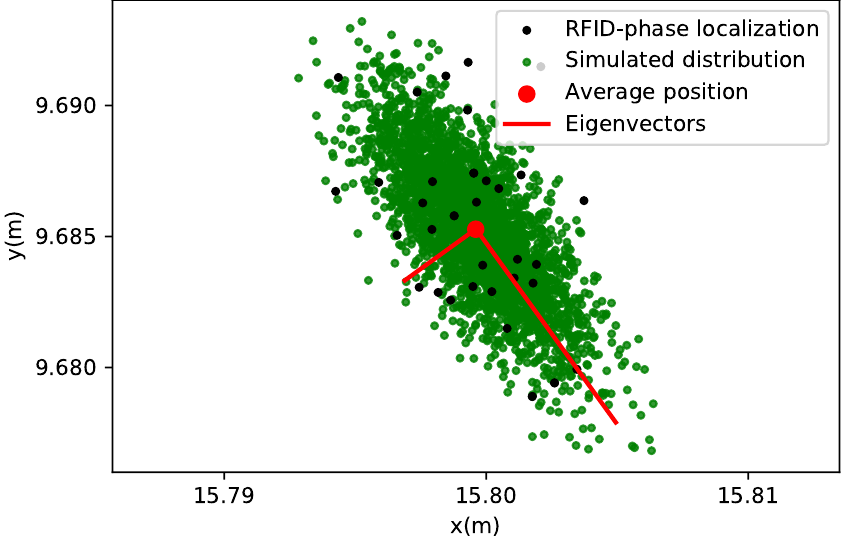
Figure 2. Localization error shape at the position of tag A (see Figure 1) compared with the RFID position estimation during a stable period in the Harmalière (November to December 2020). The green point distribution is computed through the K − 1 transformation (see Equation (6)), using a Gaussian phase distribution with a standard deviation of 0.04 rad. The eigenvectors of the green distribution (red lines) are scaled up to encompass 97% of the data. The black points correspond to the RFID-phase localization results. The antenna positions are set as in the real experiment (see Figure